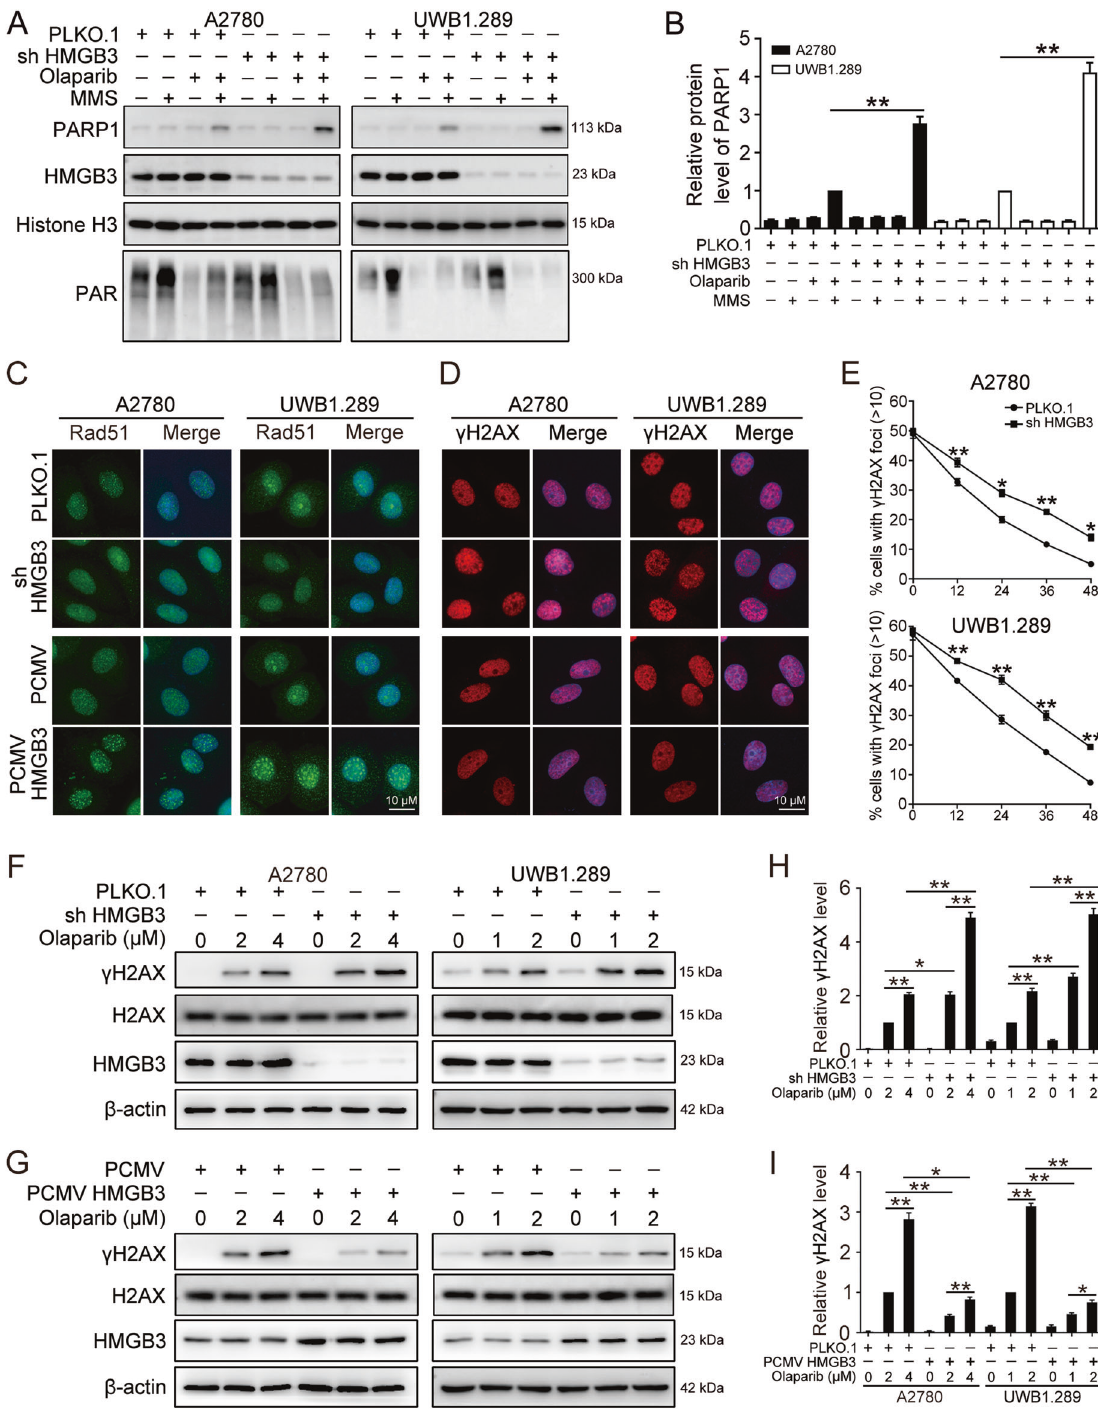
Fig. 6 HMGB3 prevents PARP1 trapping and confers DNA repair upon olaparib treatment. A A2780 and UWB1.289 cells transfected with PLKO.1 and HMGB3 shRNA (shHMGB3) were treated with olaparib (A2780, 4 µM; UWB1.289, 2 µM) for 4 h prior to incubation with 4 mM MMS for 20 min. Western blot was conducted to detect the protein levels of PARP1 in the chromatin-bound fractions. B Quanti fi cation of the PARP1 protein levels in ( A ). C , D A2780 and UWB1.289 cells transfected with PLKO.1, HMGB3 shRNA (shHMGB3), PCMV, and PCMV HMGB3 were treated with olaparib (A2780, 4 µM; UWB1.289, 2 µM) for 72 h. Rad51 and γ H2AX foci were examined by immuno fl uorescence staining. Scale bar: 10 µm. Quanti fi cation of the number of γ H2AX and RAD51 foci (>10) can be found in Fig. S6B. E A2780 and UWB1.289 cells transfected with PLKO.1 and HMGB3 shRNA (shHMGB3) were treated with olaparib (A2780, 10 µM; UWB1.289, 5 µM) for 24 h. After that, olaparib was removed and fresh drug free media was added. Cells were cultured further and γ H2AX foci were observed at 12 h, 24 h, 36 h, and 48 h post drug removal. F , G A2780 and UWB1.289 cells transfected with PLKO.1, HMGB3 shRNA (shHMGB3), PCMV, and PCMV HMGB3 were treated with olaparib (A2780, 2 µM and 4 µM; UWB1.289, 1 µM and 2 µM) for 72 h. The protein level of γ H2AX was detected by western blot. H , I Quanti fi cation of the protein level of γ H2AX in ( F ) and ( G ), respectively. (Data are presented as the mean ± SEM, * p < 0.05, ** p < 0.01, n = 3).